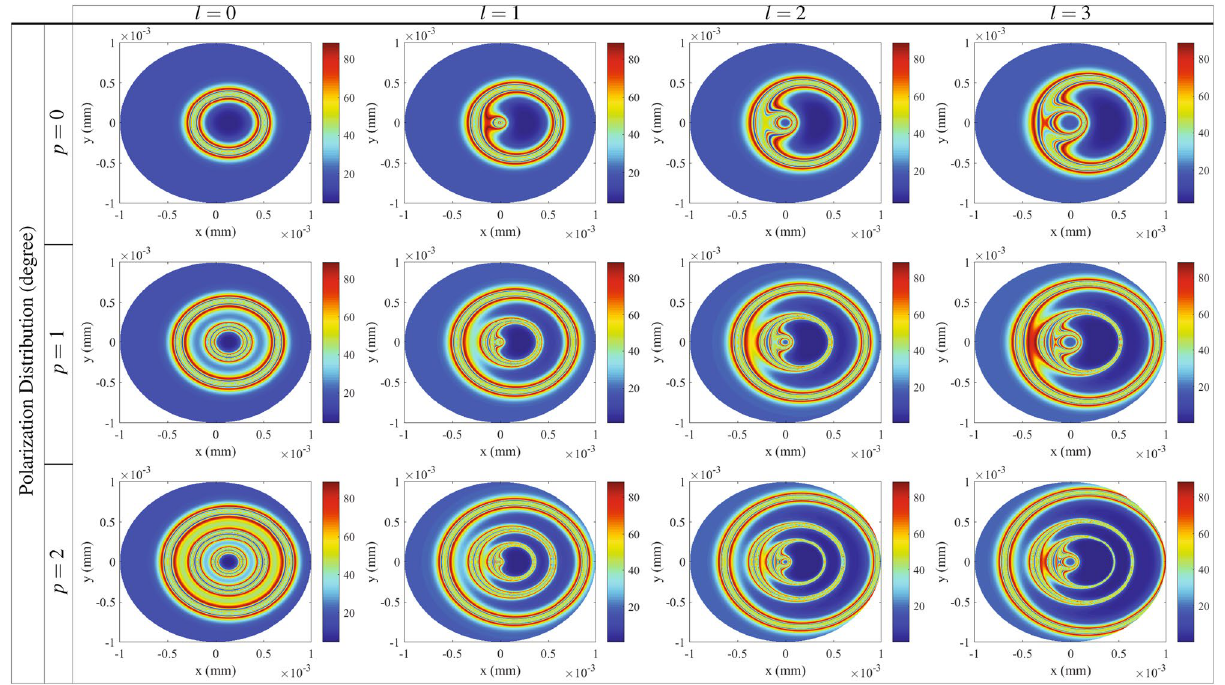
Figure 8. Polarization distribution of the VBs in unit of degree as a function of x and y for different OAMs of 1 (first row), p 2 (second row) and p 3 (third row) of the aLG control field. the shift the radial indices p = = = 0.5 wLG . Other parameters are those taken in Fig. 2 parameter a is equal to a =